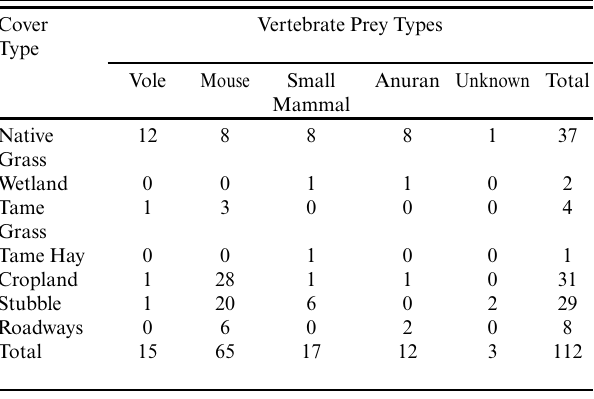
Table 1 . Summary of vertebrate prey captures for each land-cover type by Burrowing Owls ( Athene cunicularia ) in Alberta and Saskatchewan, 2009-2010. “Small mammal” refers to an item that was positively identified as a small mammal, but could not be categorized further. “Unknown” deliveries were identified as vertebrates, but could not be categorized